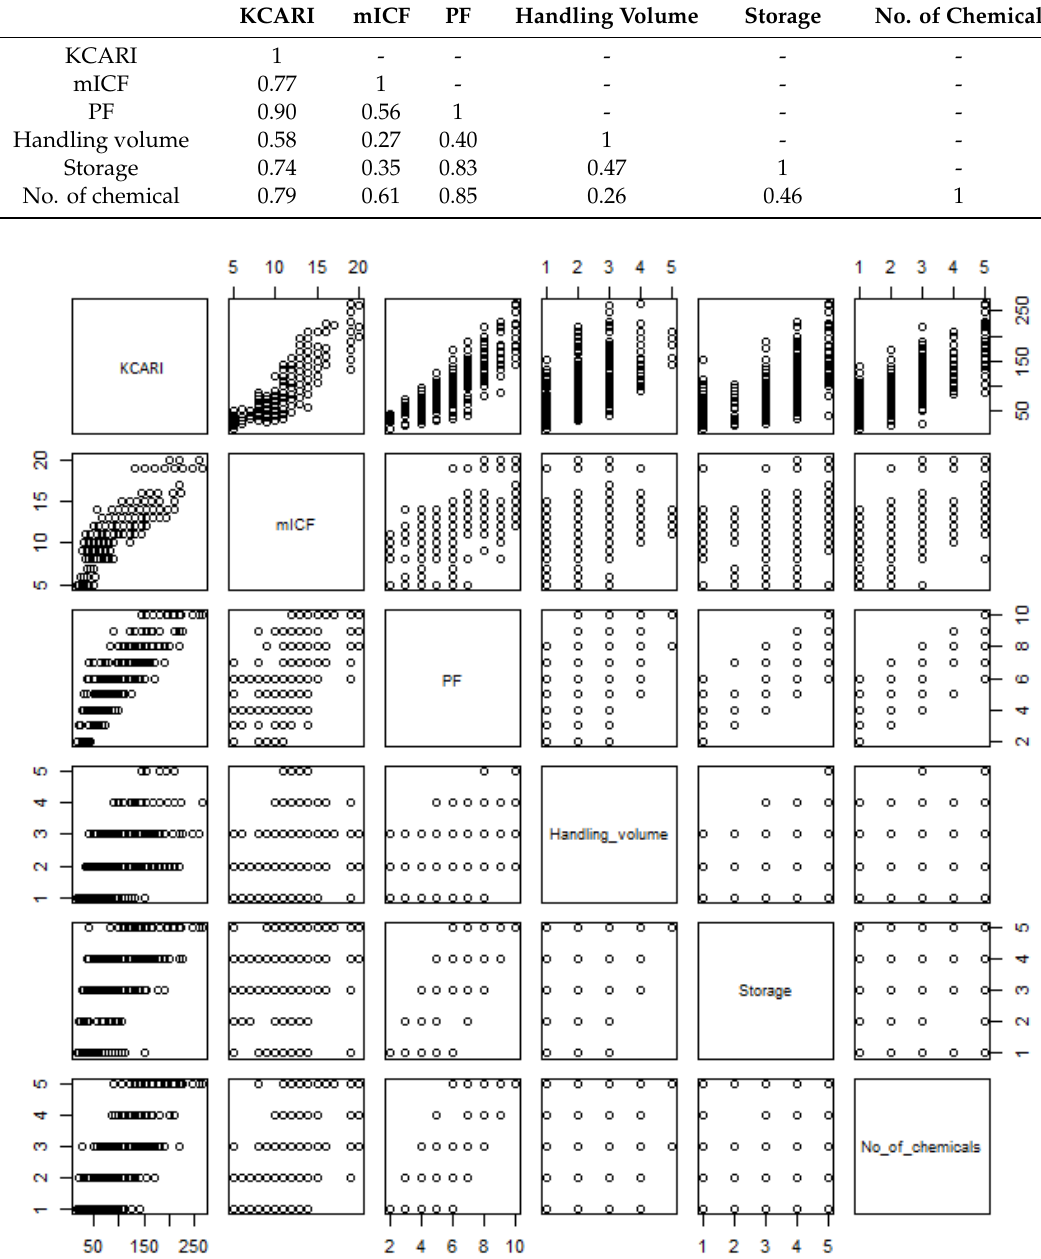
Table 4. Correlation coefficients of the index, factors, and sub-indices of PF.